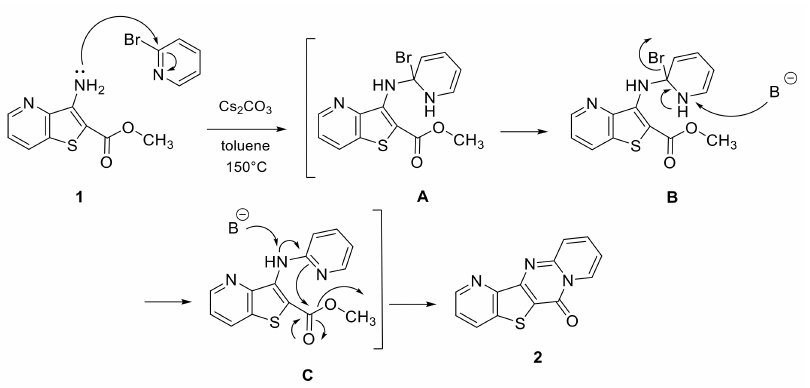
Scheme 2. Plausible